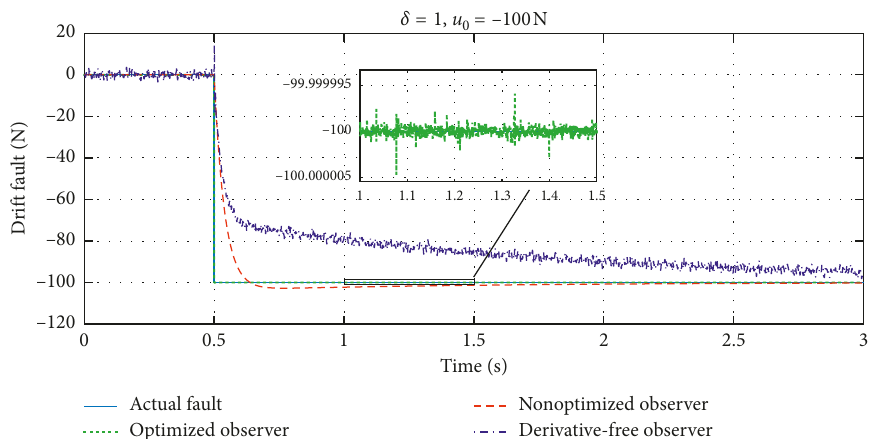
Figure 3: Tracking effects of the drift fault ( random road